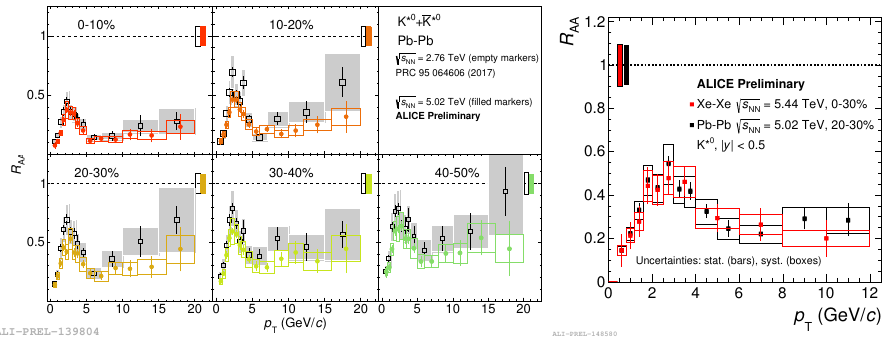
Figure 6. (color online) The nuclear modification factor R AA for K ∗ 0 as a function of transverse mo- √ √ s NN = 2.76 TeV [6] and s NN = 5.02 TeV in di ff erent centrality. mentum. (left) Pb-Pb collisions at (right) Xe-Xe and Pb-Pb collisions at the same multiplicity (and not just centrality